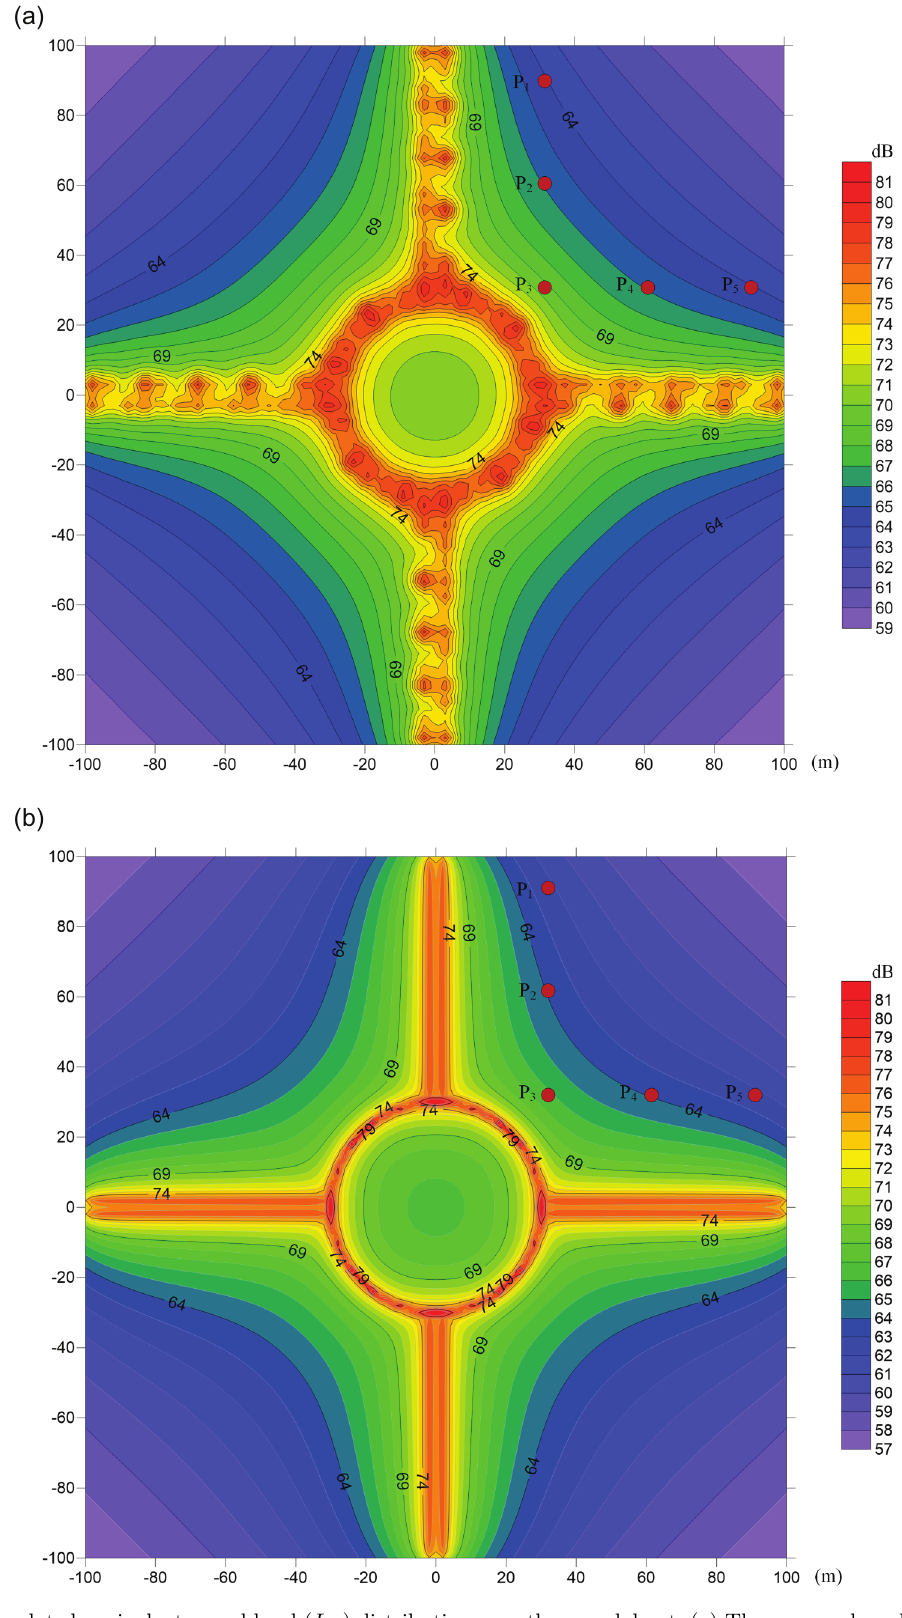
Figure 10. The simulated equivalent sound level ( L eq ) distribution near the roundabout. (a) The proposed model with a = 0.1 and Q (cid:5) 1440 veh/h; (b) the model given in Ref. [29] with Q (cid:5) 1440